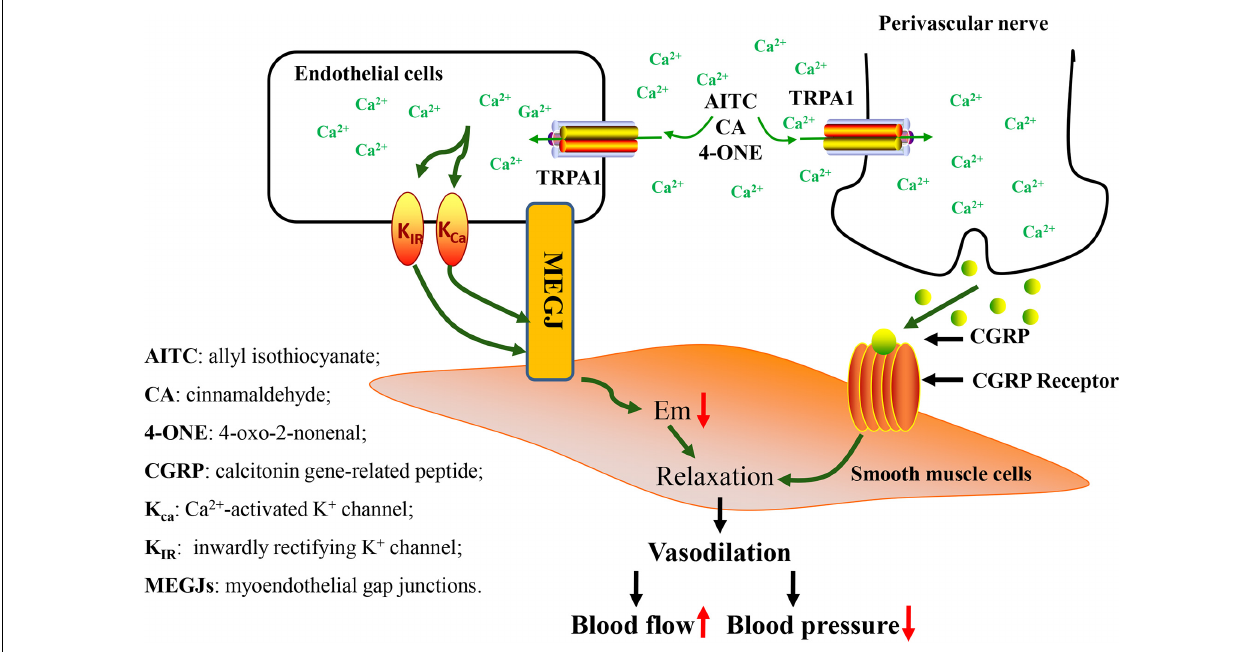
FIGURE 2 | Vascular physiological changes caused by activation of TRPA1 channel. Activation of the TRPA1 channel causes Ca 2 + influx, leading to hyperpolarization of endothelial cell membranes. This change in potential causes hyperpolarization of smooth muscle cell membranes, causing relaxation of muscle cells. In addition, activation of the TRPA1 channel induces an increase in [Ca 2 + ], which leads to the release of the neuropeptide CGRP from perivascular nerve, thereby mediating vasodilation. Vasodilation causes changes in blood flow and blood pressure.